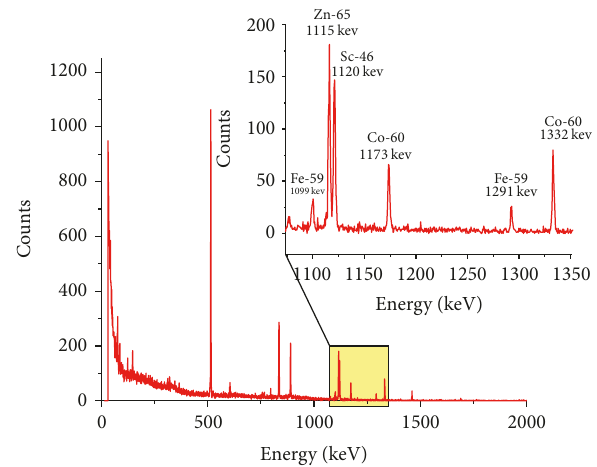
Figure 7: Same as Figure 6 but after the adsorption of elements in the